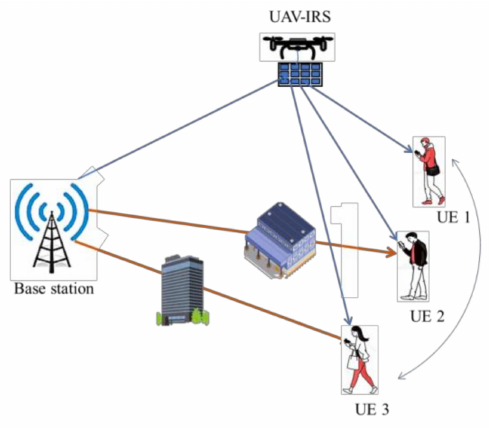
Figure 8. Illustration of a UAV-IRS-assisted MEC application